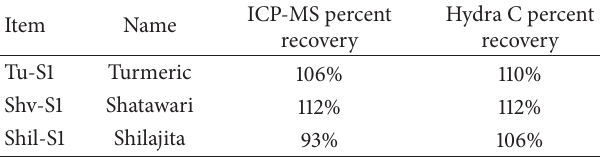
Table 1: Percent recoveries of Hg spikes by ICP-MS and Hydra C.